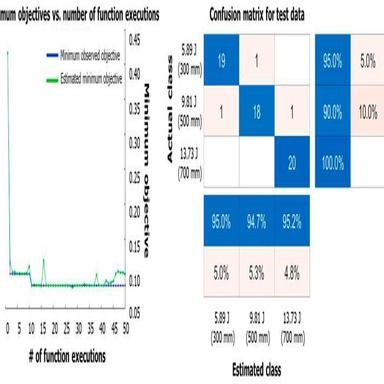
Performance evaluation results for the optimized CNN-based deep learning model for failure characterization.